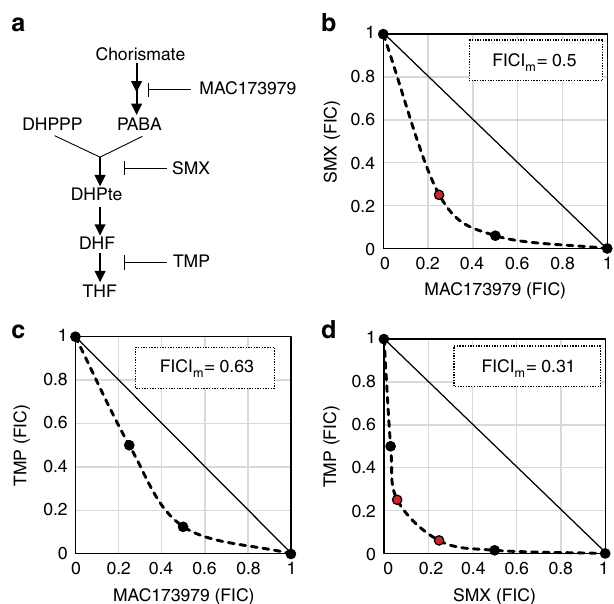
Table 1 MICs of SMX, TMP, and MAC173979 and FICI m